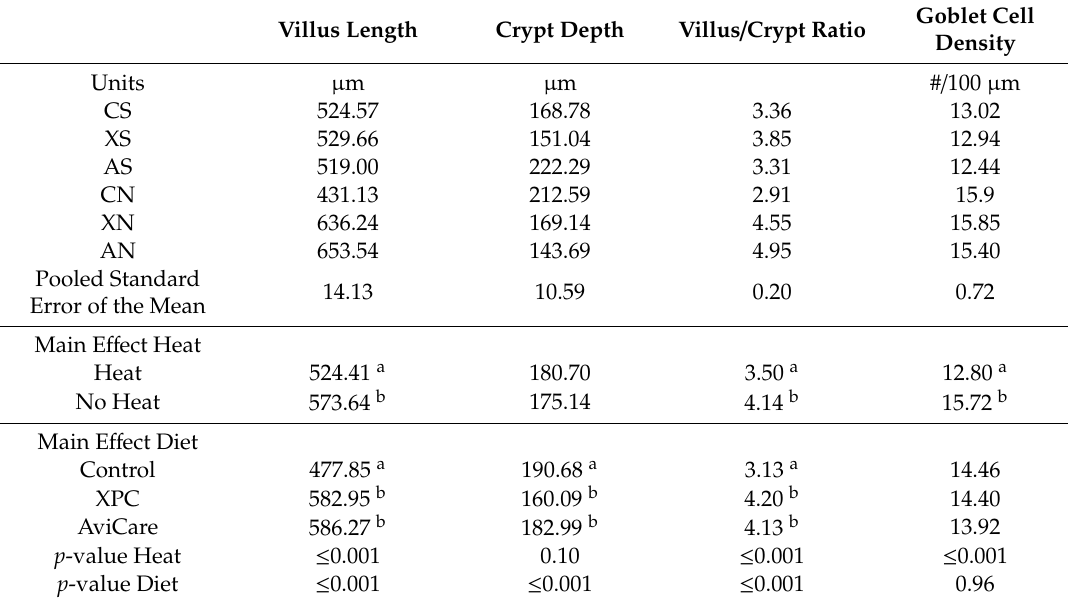
Table 5. Average ileal measurements in straight run white Pekin ducks after 34 d of growth 1